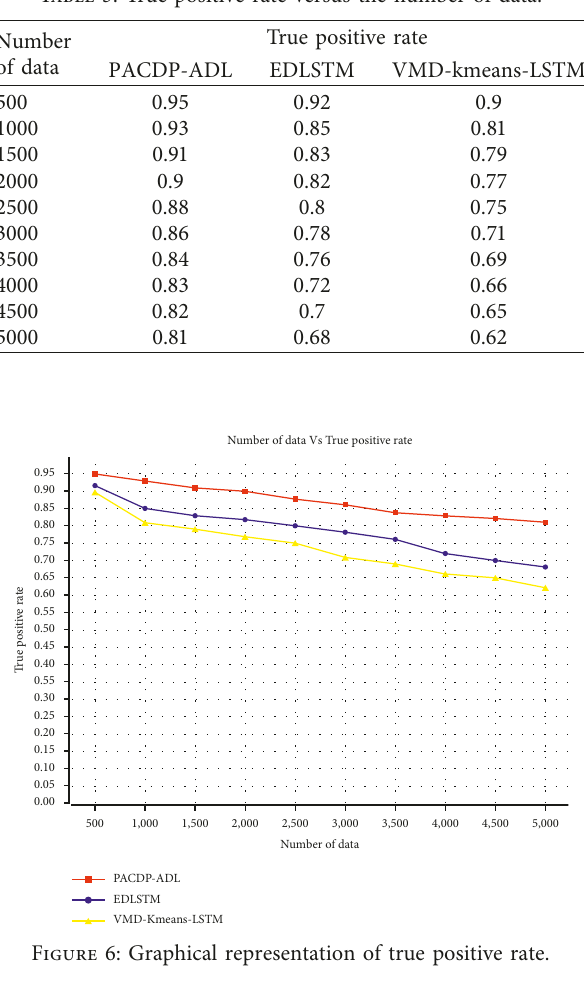
Table 2: Wind power prediction time versus the number of data.